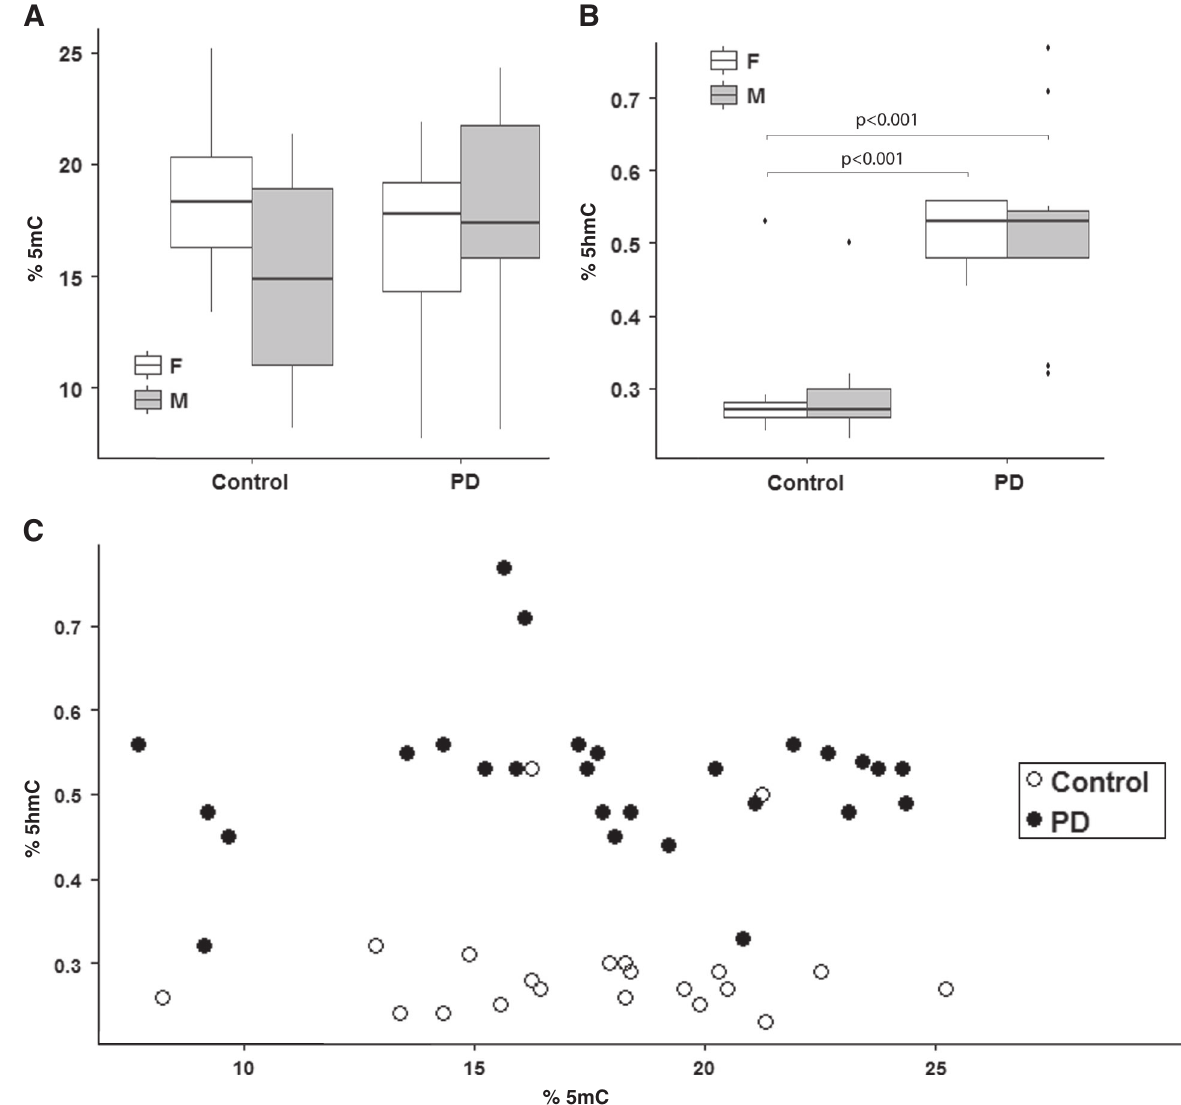
Fig. 1 Quantitation of 5mC and 5hmC in DNA of the cerebellum from age-matched control ( n = 27; 11 females, 16 males) and PD individuals ( n = 36; 12 females (F), 24 males (M)). Data are presented as box-and-whisker plots and indicate the full range, interquartile range, and median value in each group. Error bars represent SEM ( a , b ). The scatter plot depicts 5hmC and 5mC levels for individuals of the control and PD group ( c